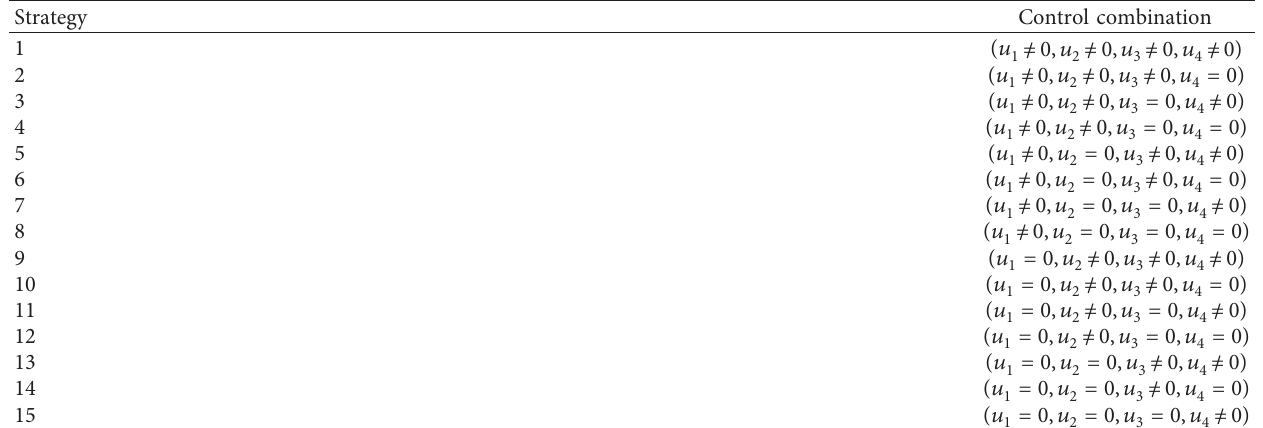
Figure 3: Time series of S , E , I , and I at 100% implementation of controls with extended and temporary border closure ( R 1 2 Table 3: List of all strategies used for the simulation of the optimal control problem. Strategy Control